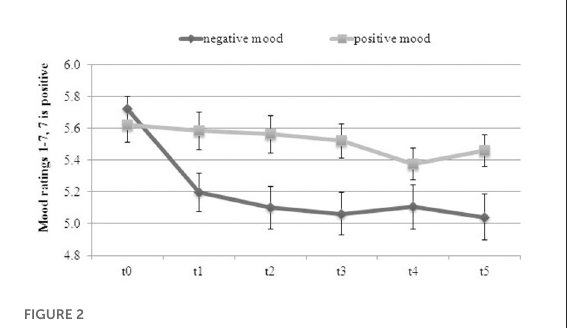
FIGURE2 Averaged mood ratings at the baseline (t0) and the end of each block (t1, t2, t3, t4, t5), on a 1-7 scale (1 = negative mood state; 7 = positive mood state). The error bars are standard